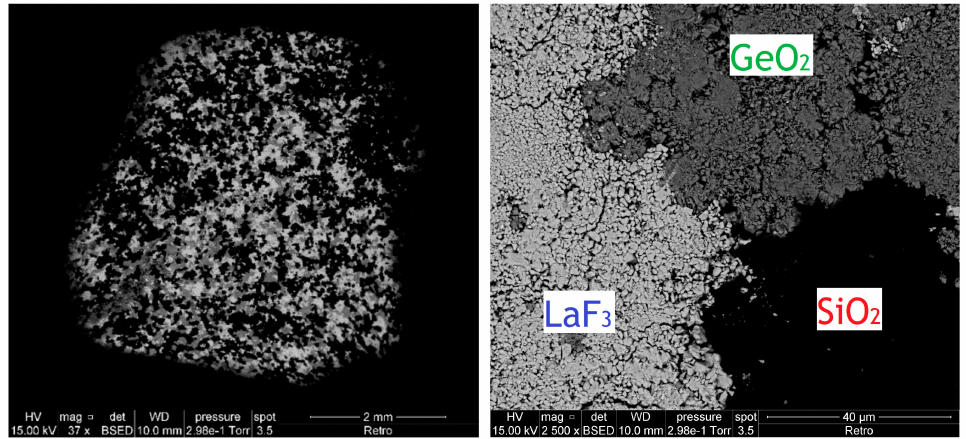
Figure 1. SEM images by backscattered electrons of a mixture of three compounds before thermal treatment: SiO 2 (black), GeO 2 (dark gray) and LaF 3 (light gray).